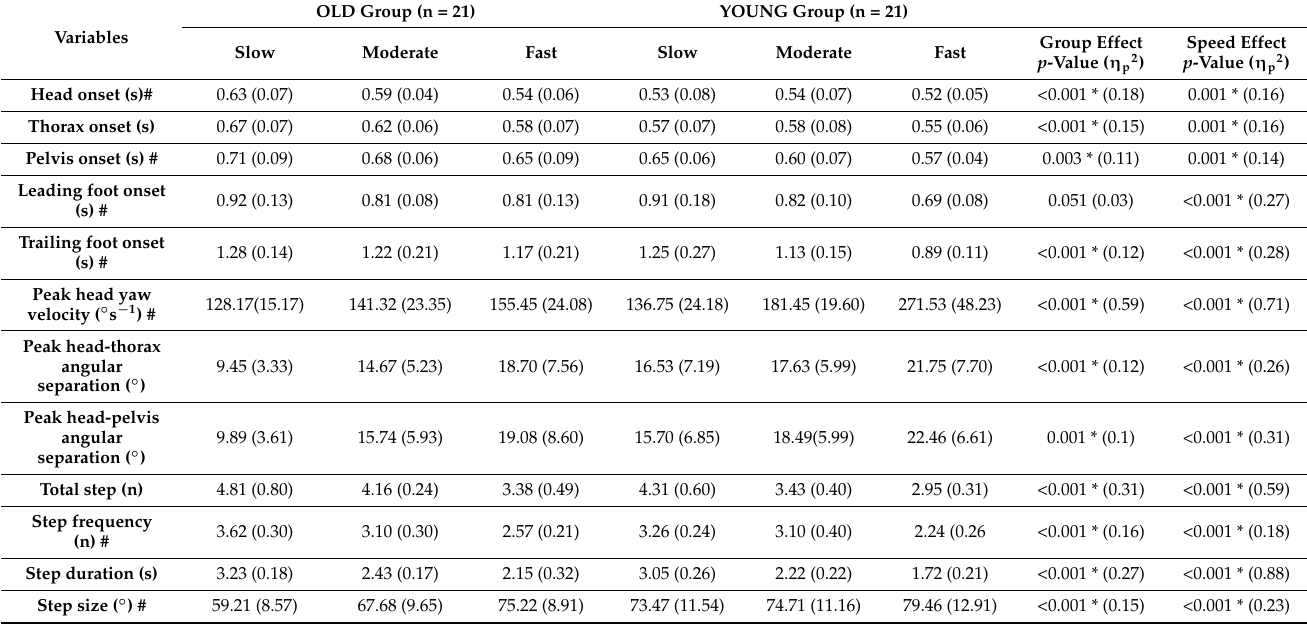
Table 1. Mean and standard deviations (SD) and interaction between group and turning speed for whole-body coordination and stepping characteristics variables which performed by MM